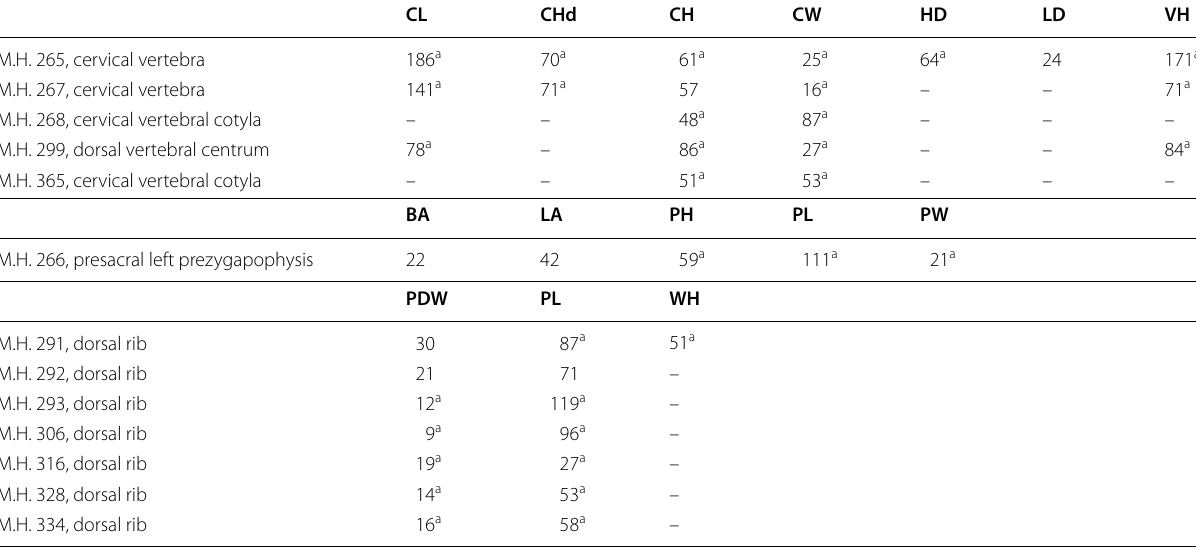
CL centrum length, CHd centrum height at diapophysis, CH centrum height at condylus/preserved height of vertebral cotyla, CW centrum width at condylus/ preserved width of vertebral cotyla, HD preserved dorsoventral height of diapophysis, LD minimum (distal) craniocaudal length of diapophysis, VH total vertebral height, BA maximum breadth of articular surface, LA length of articular surface, PH preserved height, PL preserved length, PW preserved width, PDW preserved distalmost shaft width, PL preserved length, WH width at rib head. All measurement are in mm a Indicates that the measurements refers only to preserved dimension at the incomplete and compressed bone